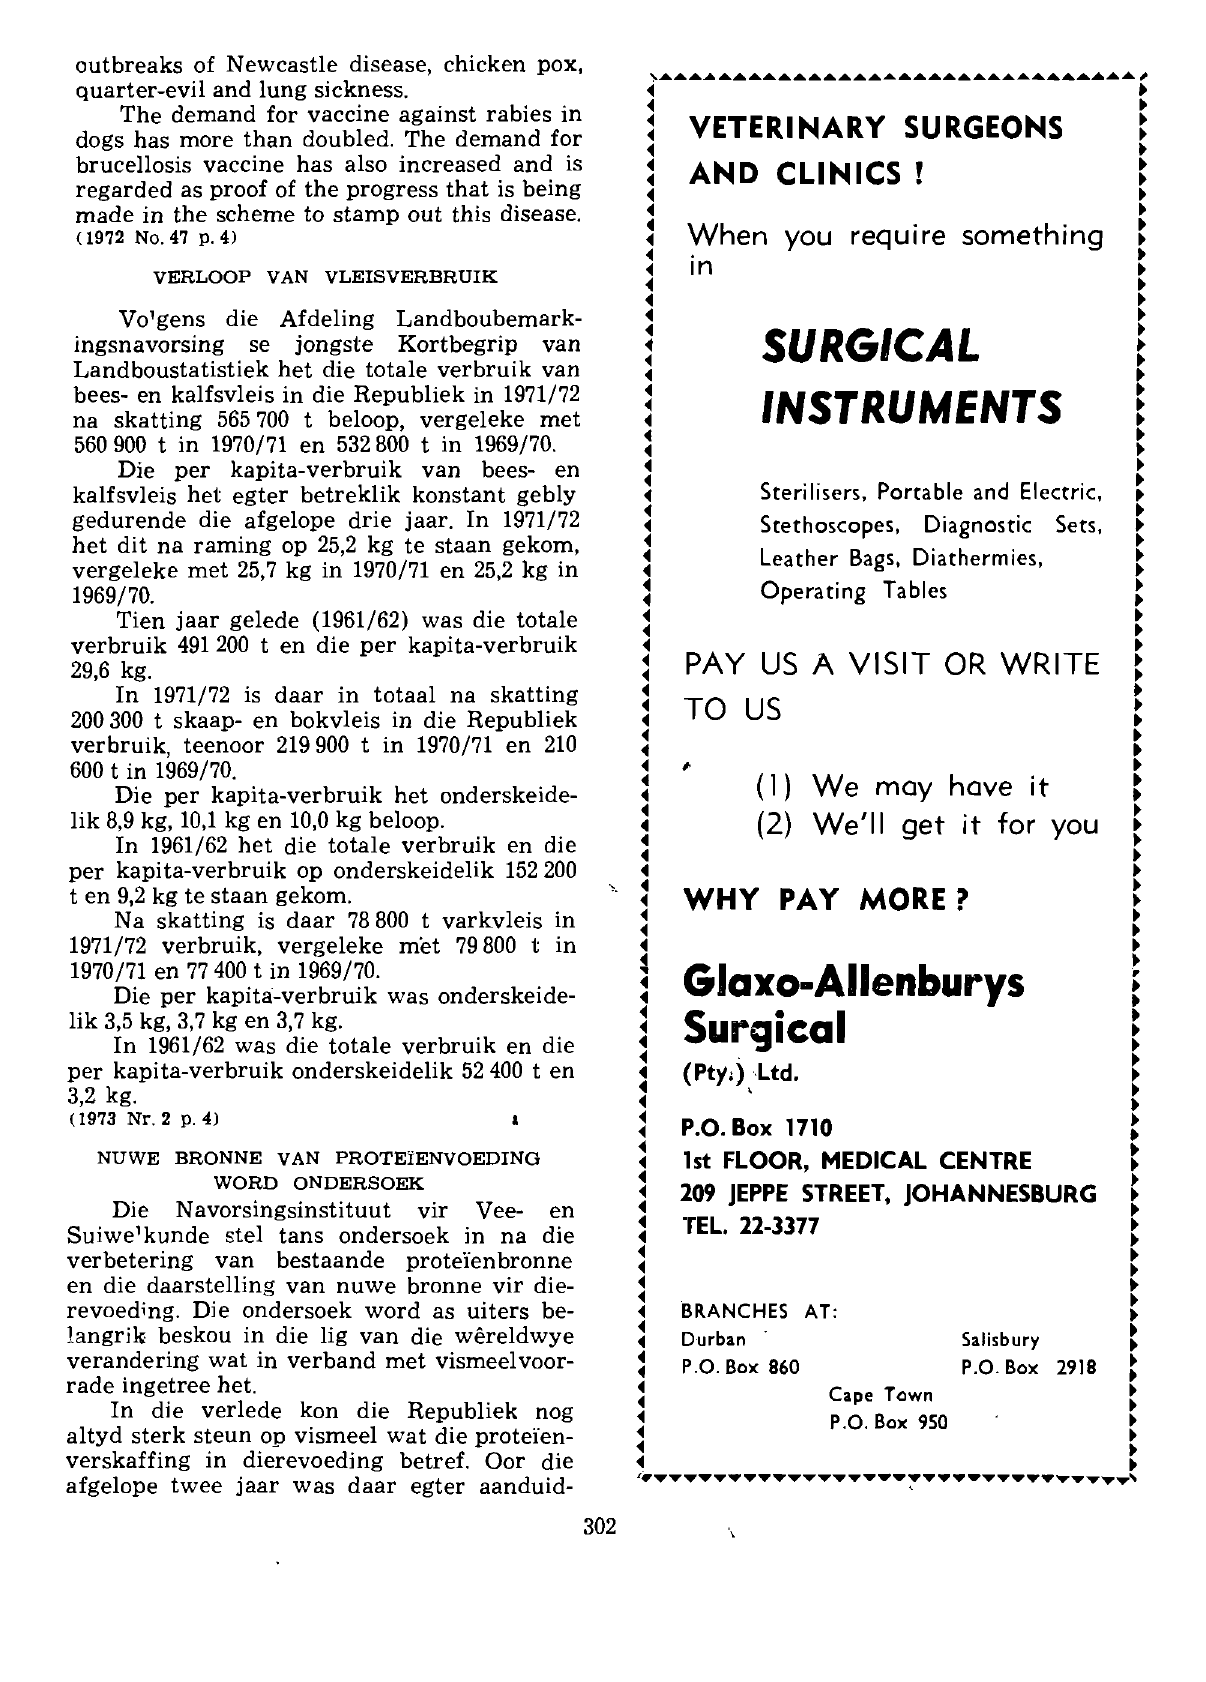
INSTRUMENTS .. Sterilisers, Portable and Electric, .. Stethoscopes, Diagnostic